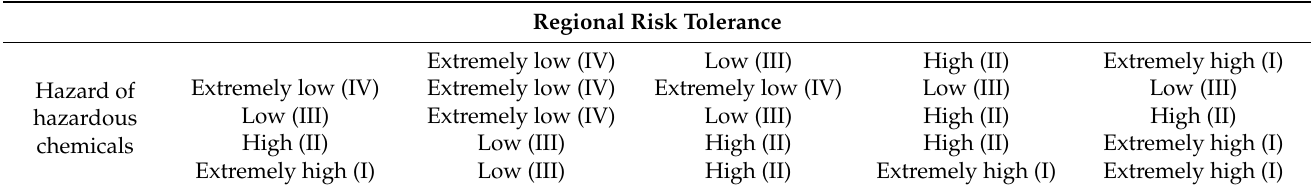
Table 5. Risk-assessment-level relationship of dangerous chemicals leaking into the sea area.